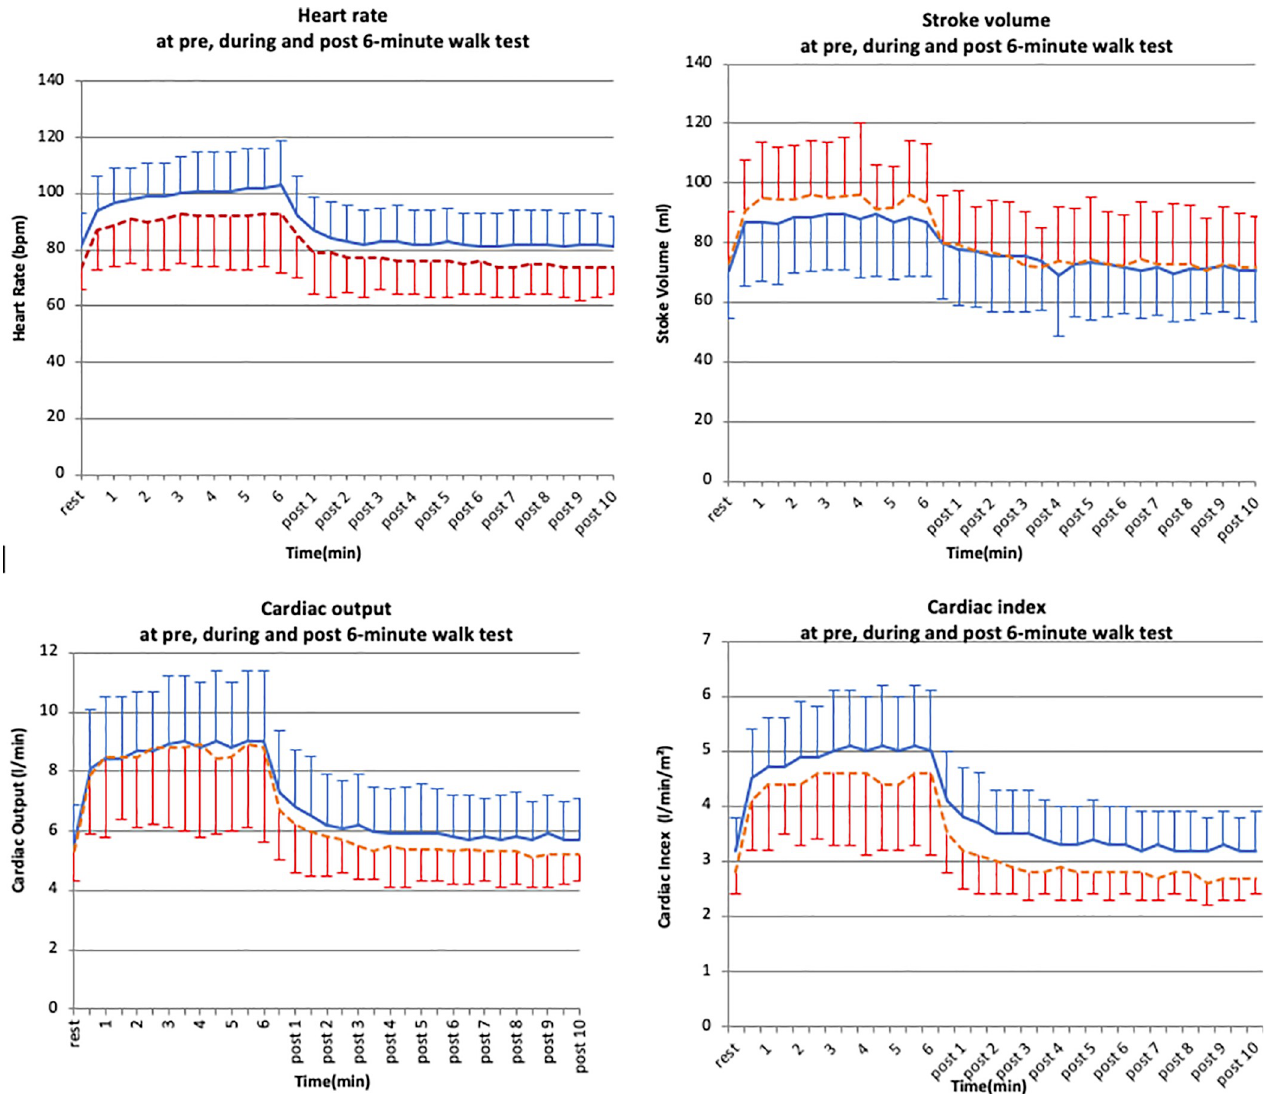
Fig 3. Cardiodynamic changes during the 6MWT in participants post-stroke duration of less or longer than 1 year. Solid line= time elapsed after stroke less than 1 year; dotted line=time elapsed after stroke longer than 1 year.